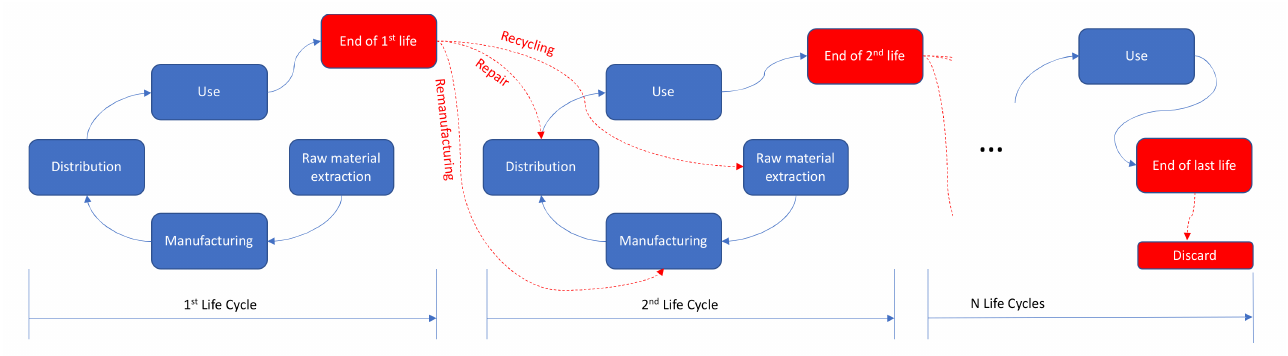
Figure 1. Life cycle of the M-PLC